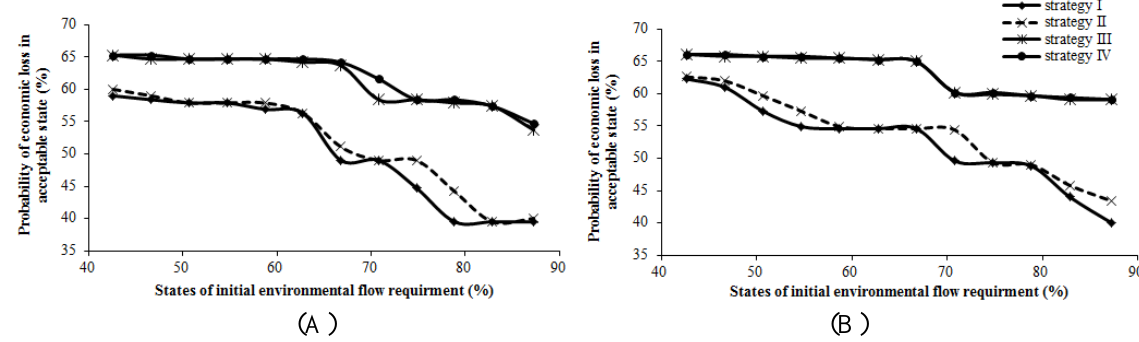
Figure 9 Fig. 9. Comparisons of the probability distributions of acceptable economic loss among different water management strategies for the irrigation stakeholders of (A) winter wheat, and (B) summer